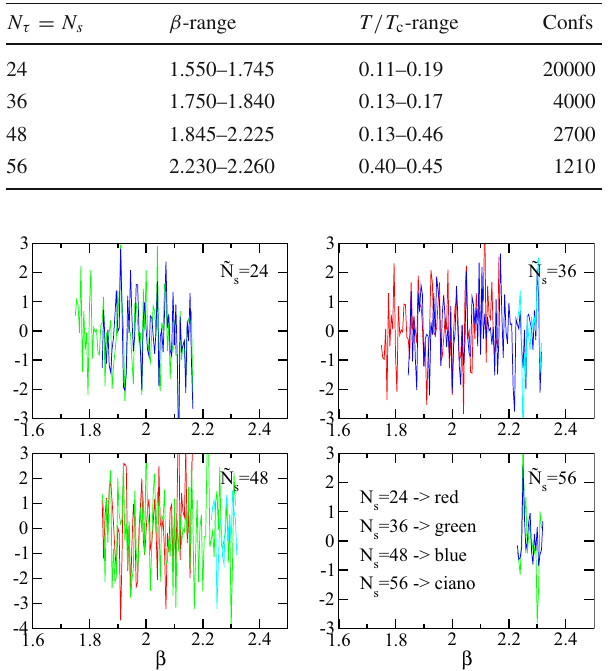
each single plot. From this figure it is clear that the “residual” temperature and the finite volume effects are always smaller than the statistical fluctuation of our measurements. The error in the determination of our observables depends on the error on the action density N 4 τ [ (cid:6) S (cid:7) 0 − (cid:6) S (cid:7) T ]. It is